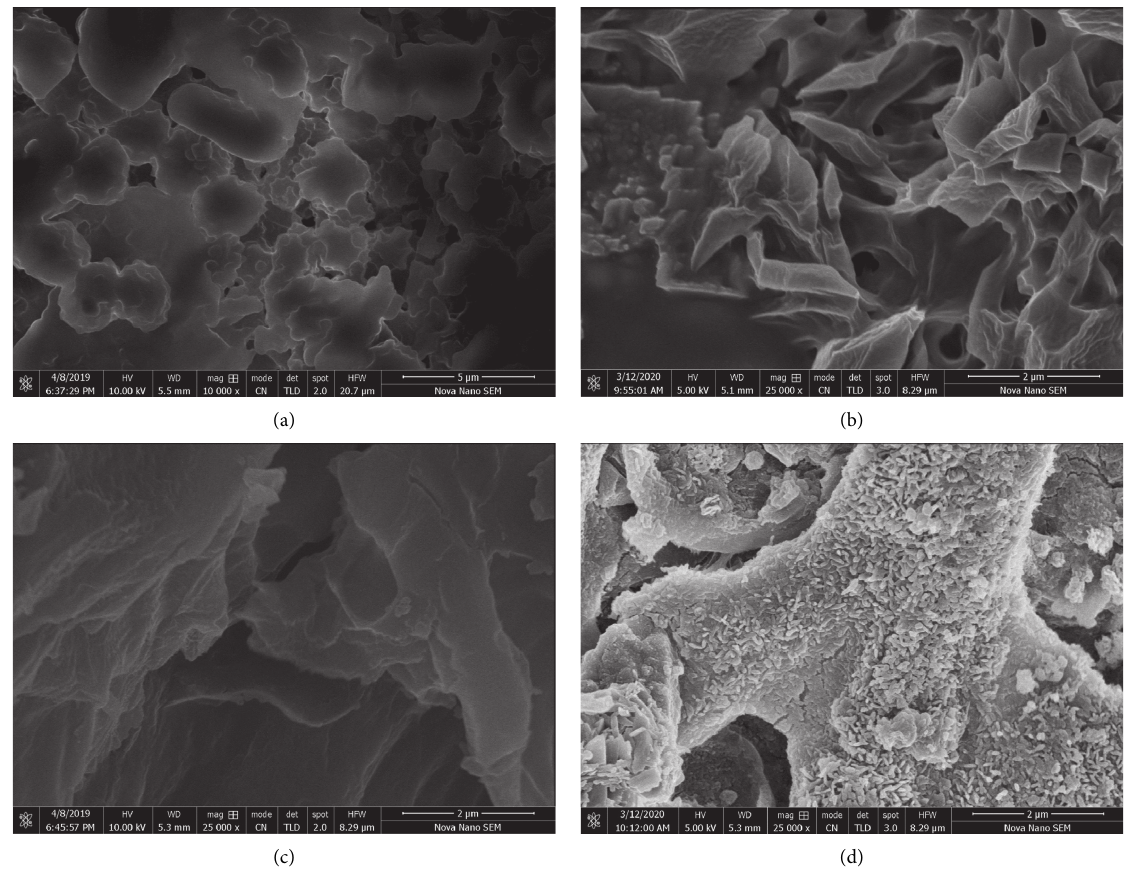
Figure 3: SEM images of (a) Ha, (b) Ha-Ta, (c) Cc, and (d)